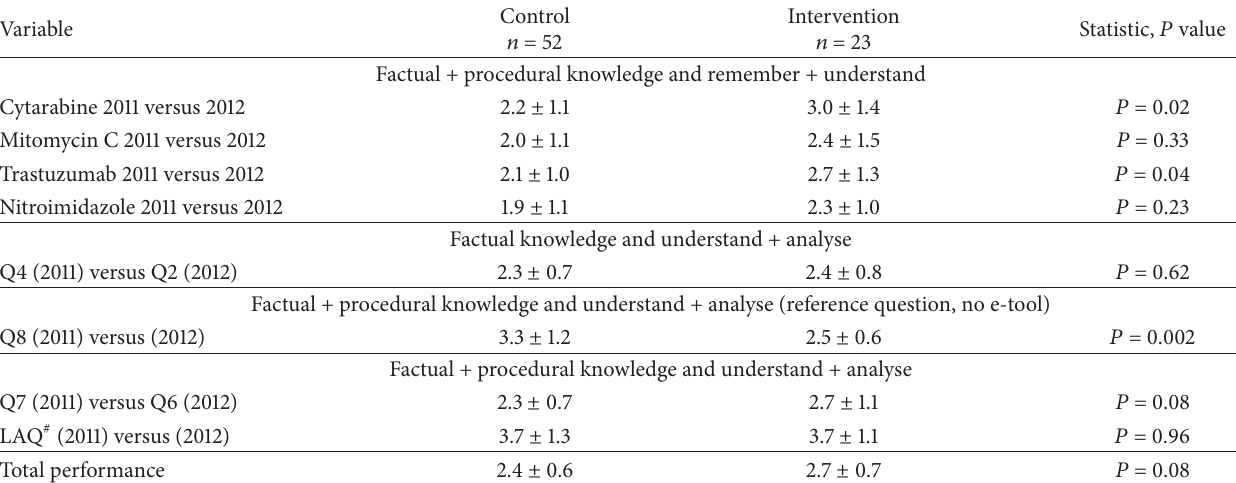
Table 5: Student level of understanding in semester two